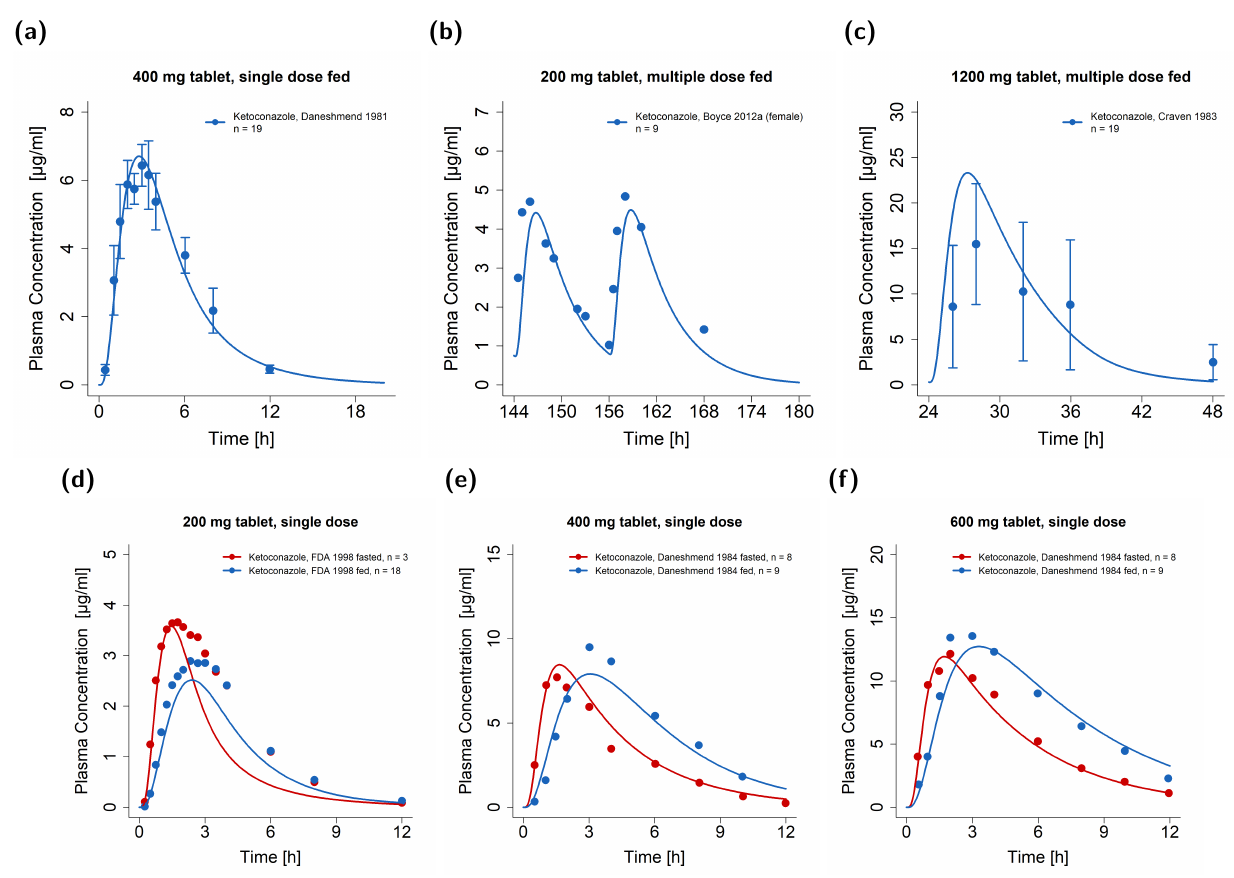
Figure 3. Ketoconazole DFI model performance. Illustrated are plasma concentration-time pro- files of exemplary clinical trials of ( a – c ) single- and multiple-dose administrations of tablets in fed state [46,48,50]. Moreover, comparisons of fasted (red) and fed (blue) predicted and observed plasma concentration-time profiles are illustrated for 200 mg ( d ), 400 mg ( e ), and 600 mg ( f ) single-dose administrations of ketoconazole [6,49]. The model predictions are shown as solid lines and the corresponding observed data as dots (arithmetic mean). Detailed information on the study protocols is provided in Table S1.2 in the Supplementary Materials. fasted: fasted condition; fed: fed condition; n: number of